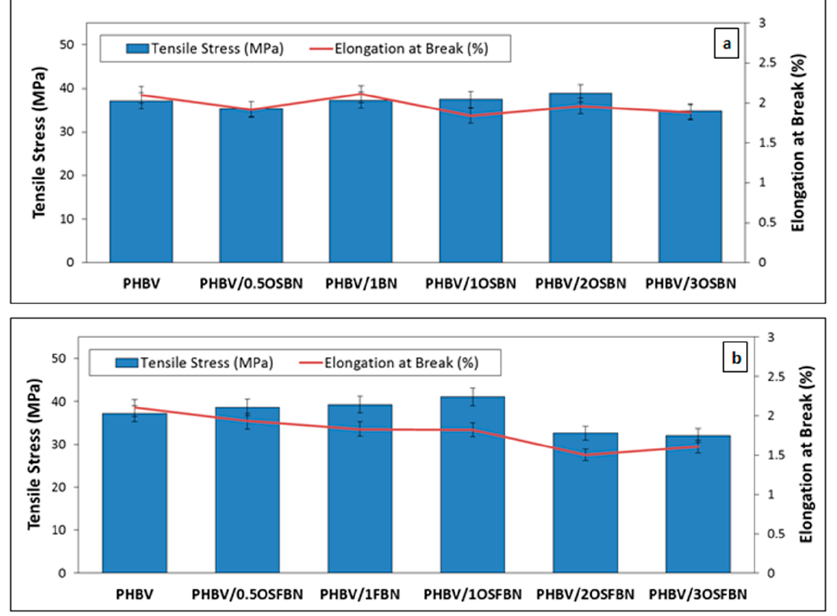
Figure 10. Tensile stress and elongation at break values of ( a ) PHBV/BN and ( b ) PHBV/FBN nanocomposites.